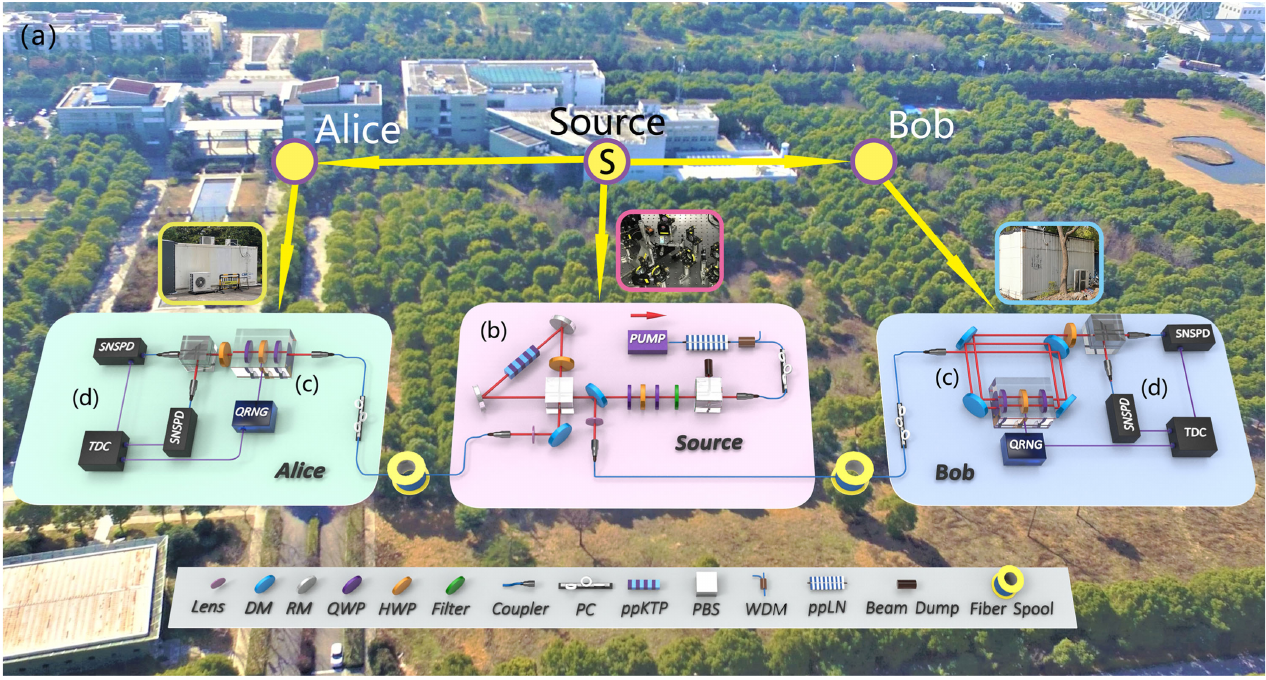
FIG. 1. Schematics of the experiment. (a) Bird ’ s-eye view of the experimental layout. Alice and Bob are on different sides of the entanglement source, and the linear distance between Alice (Bob) and the source is 93 (cid:3) 1 ð 90 (cid:3) 1 Þ m. (b) Creation of pairs of entangled photons: By injecting a 1560-nm-wavelength laser into the periodically poled lithium niobate (PPLN) waveguide, the wavelength of generated photons is up-converted to 780 nm. The pump photons of 780 nm are injected into the periodically poled potassium titanyl phosphate (PPKTP) crystal in the Sagnac loop to generate polarization-entangled photon pairs of 1560-nm wavelength. Then, the photons are sent by fibers in opposite directions to Alice and Bob for different phase shifts and measurements. (c) Realization of different phase shifts: With the combination of QWP, HWP, and QWP, the phase shift is implemented between two optical axes. HWP can be controlled by a quantum random number generator (QRNG) (see the main text for more details). (d) Single-photon polarization measurement: Photons are projected into one of the σ x bases and are then detected by superconducting nanowire single-photon detectors (SNSPDs). The time-digital convertor (TDC) is applied to record the single-photon detection and random number generation events. DM: dichroic mirror; RM: reflection mirror; PC: polarization controller; WDM: Wavelength Division